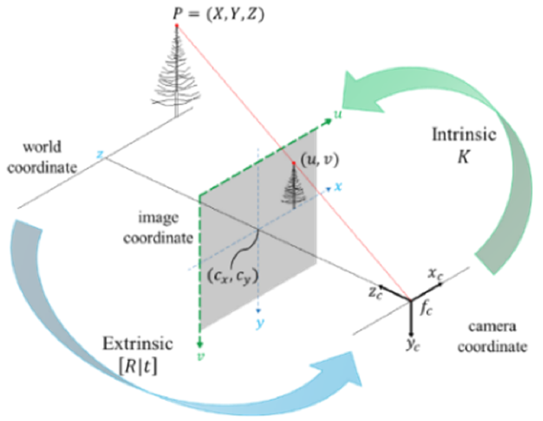
Figure 3. Projection